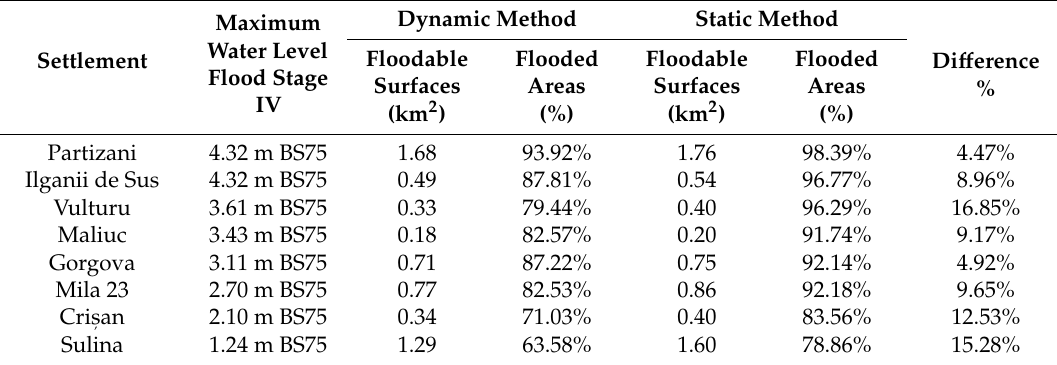
Table 5. The flooded areas of the settlements analyzed at the flood stage IV: maximum water level of the Danube.